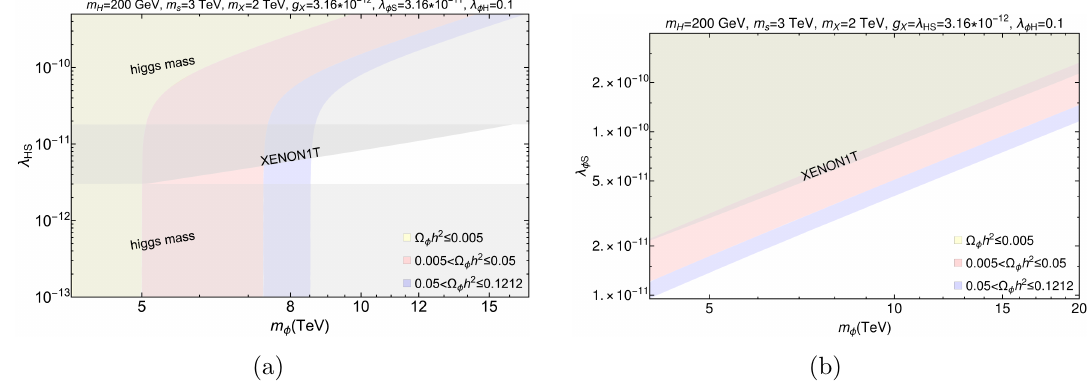
Figure 13 . Under abundance for φ ( Ω φ h 2 ≤ 0 . 1212 ) in the kinematic region m s < 2 m X . Fig- ure 13(a) shows the correlation between m φ − λ HS and figure 13(b) shows the correlation between m φ − λ φS . Different colour shades in light yellow, light red and light blue indicates under abundance within ranges as mentioned in figure inset. Grey shaded regions are excluded by latest XENON1T bound, Higgs mass and collider bound on scalar mixing (see text for details).